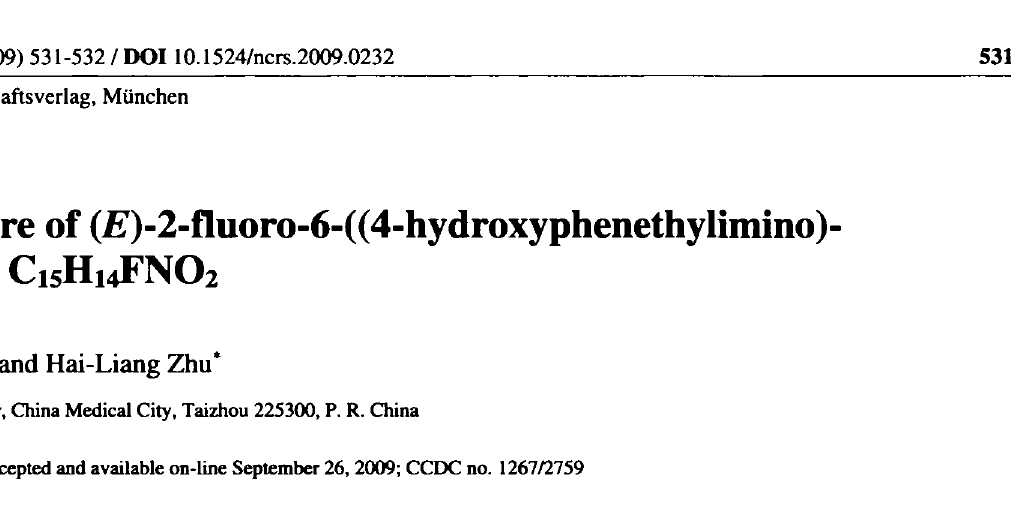
Table 1. Data collection and handling.